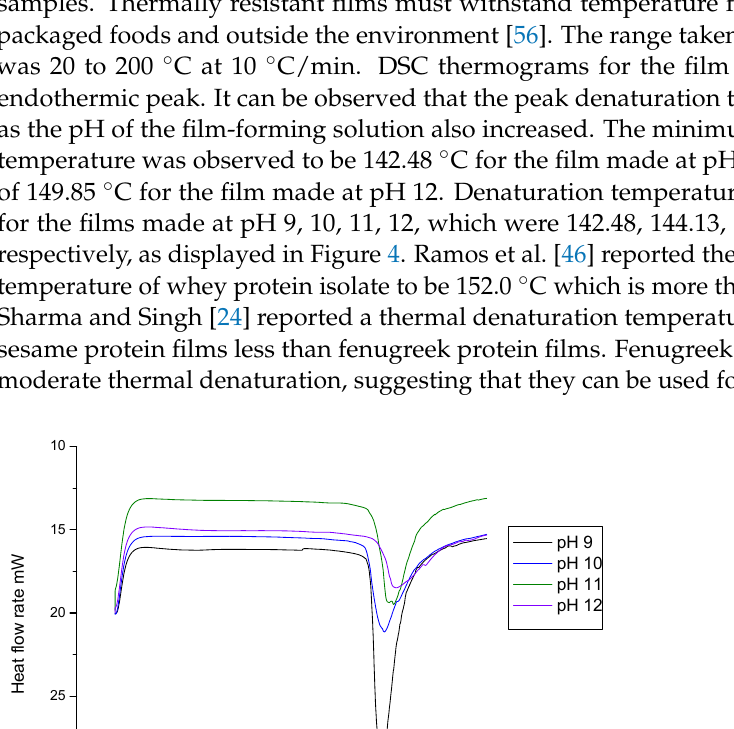
Figure 3. SEM image (×1500 magnification) of FPC edible film made at pH 9, pH 10, pH 11, and pH 12 shown as ( A – D ) respectively.